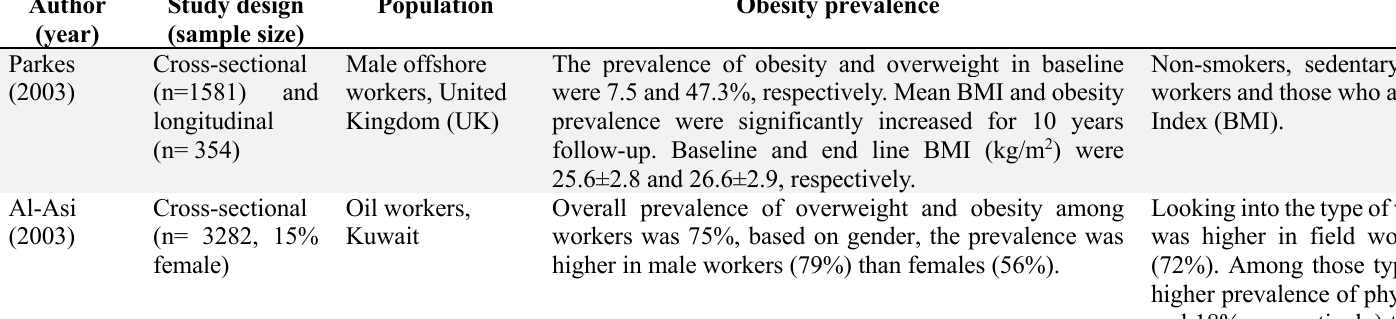
Table 2 . Studies exploring obesity in oil and gas